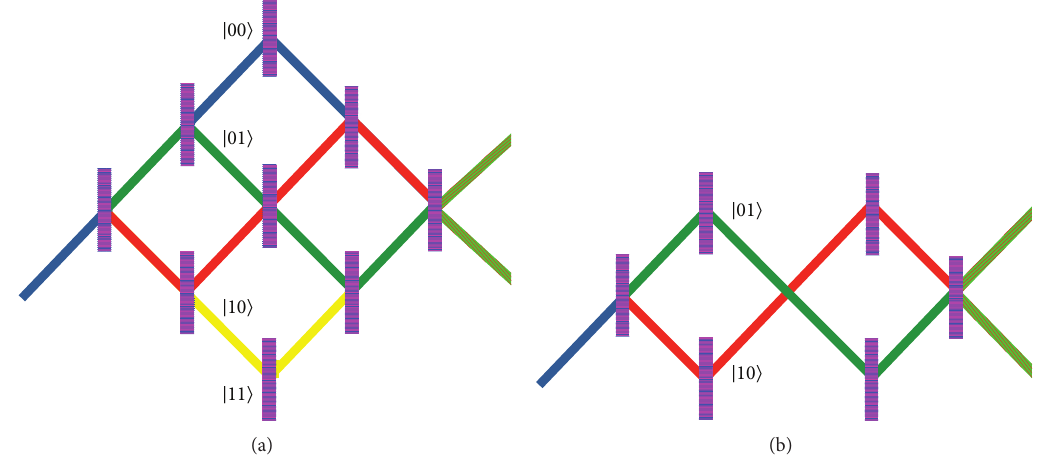
Figure 4: (a) Schematic of the 2-qubit (four paths) interferometer. (b) Schematic of the DFS interferometer.